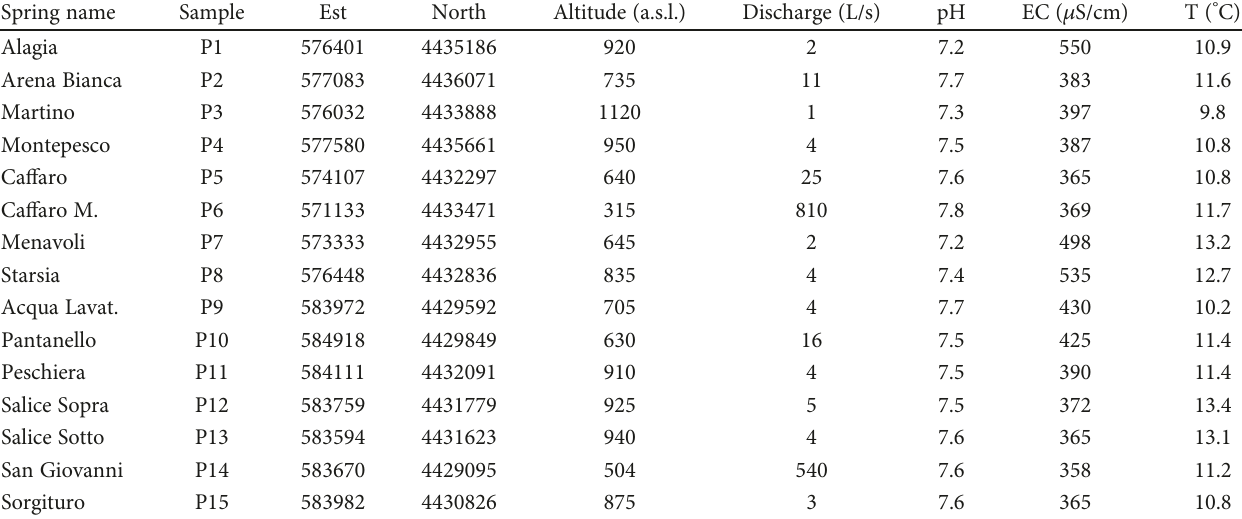
Table 1: Physicochemical parameters of the groundwater samples.